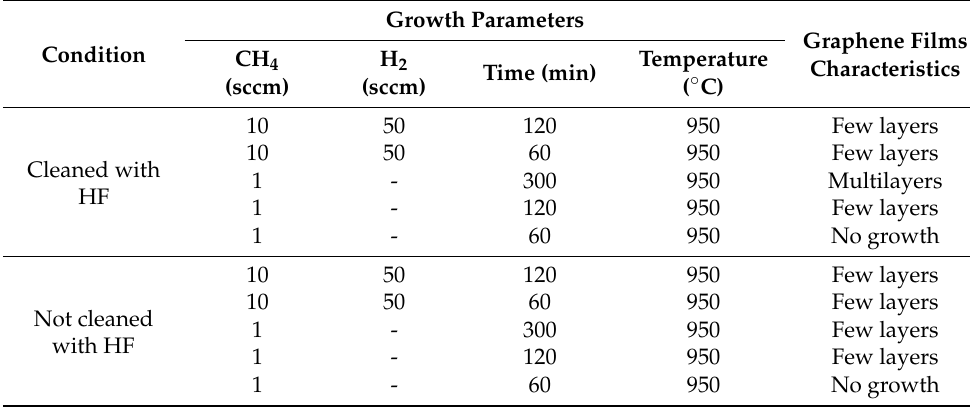
Table 1. Graphene on SiC—Growth conditions and Raman